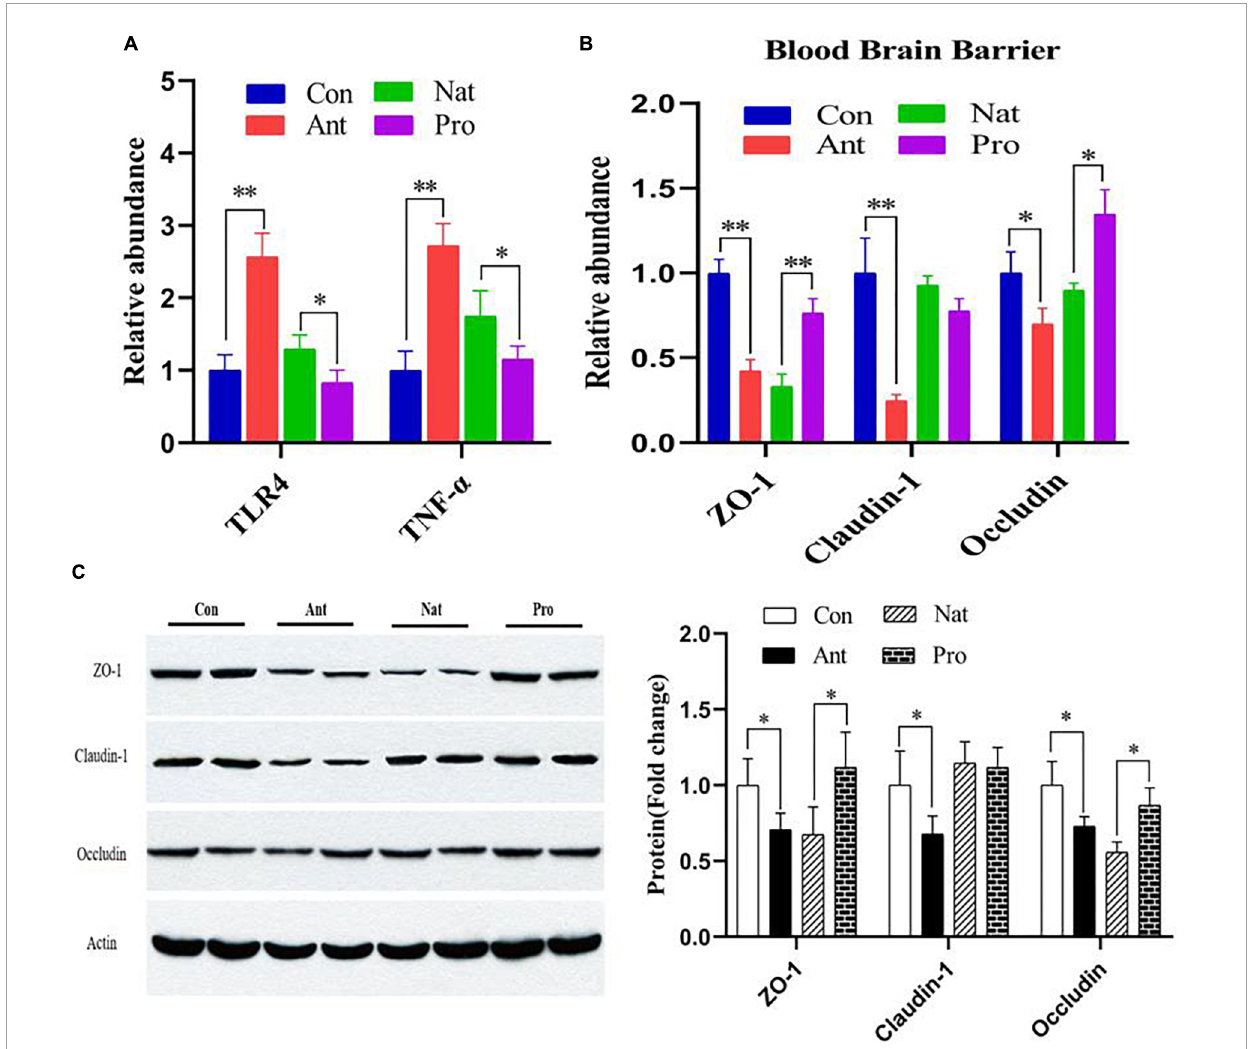
FIGURE5 Effects of dietary probiotic supplementation on the hypothalamus barrier integrity and inflammation response in the hypothalamus of antibiotic-treated hens. (A) Graph showing the relative mRNA expression of TLR4 and TNF- α in the hypothalamus of laying hens. (B) Graph showing the mRNA expression of ZO-1, Claudin-1, and Occludin in the hypothalamus of laying hen ( n = 7) following different treatments normalized to β -actin. (C) Representative Western blot (left) and quantified expression data (right) of ZO-1, claudin-1, and occludin in the hypothalamus of laying hen ( n = 4). Data presented as mean ± SD with significance defined as ∗ P < 0.05, ∗∗ P <